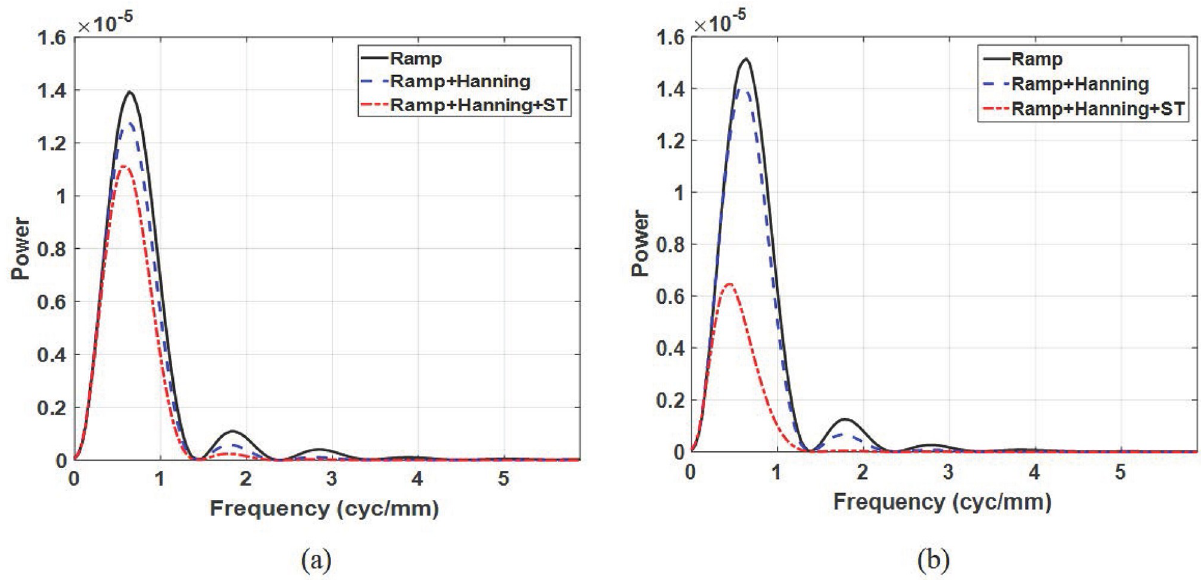
Fig 7. Signal power spectrum. Signal power spectrum for a 1 mm signal diameter with the different reconstruction filter schemes for data acquisition angles of (a) 20˚ and (b) 60˚.